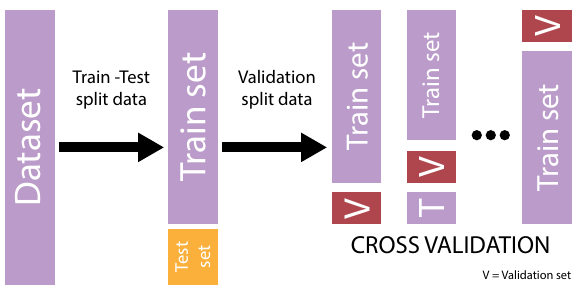
Figure 6. Workflow of dataset split and cross validation